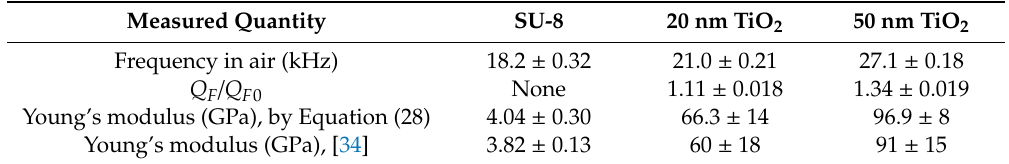
Table 1. Comparison of the Young’s modulus of atomic layer deposition (ALD) TiO 2 films calculated by Equation (28) and determined previously in [46].